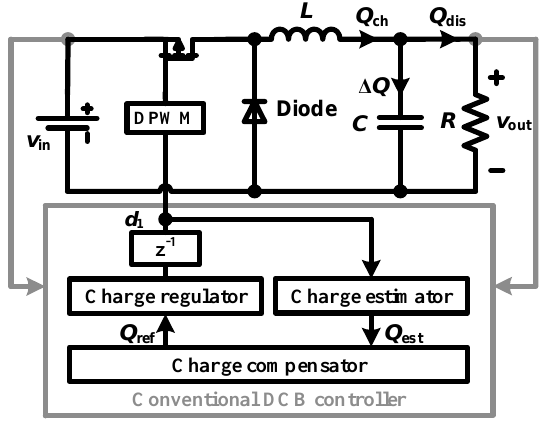
Figure 1. Buck converter under conventional discrete charge balance (DCB) control.